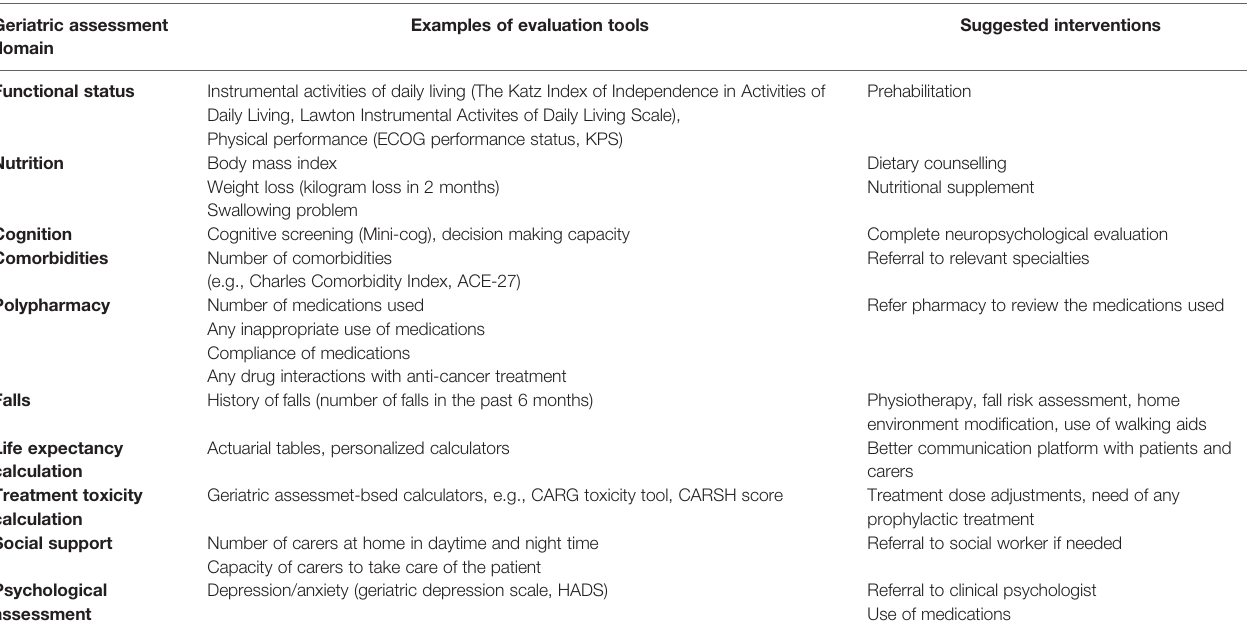
TABLE 1 | Important domains in geriatric